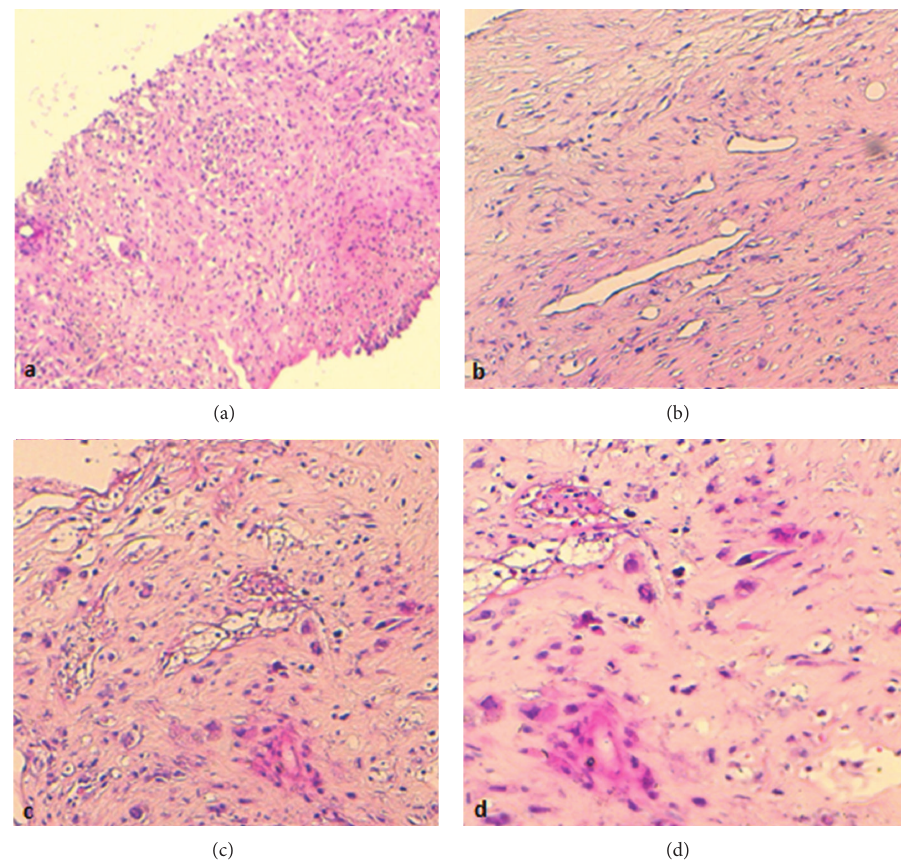
Figure 2: (a), (b), (c), and (d) Progressive increasing magnification of histology (HES 5, 10, 10, and 20, resp.) showing a tumor composed of hyperchromatic spindle cells with frequent atypical